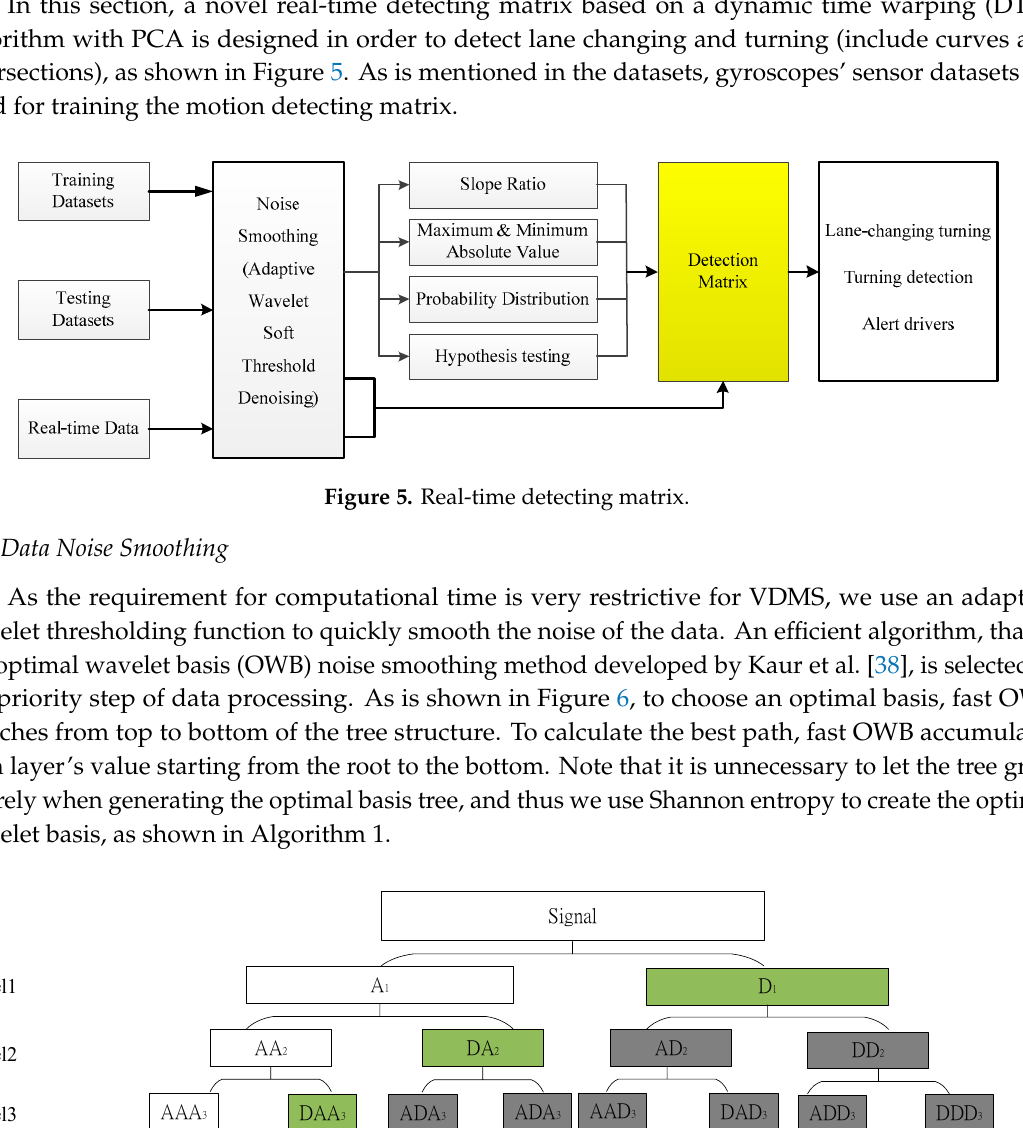
Algorithm 1: Fast Optimal Wavelet Basis (OWB) Extraction